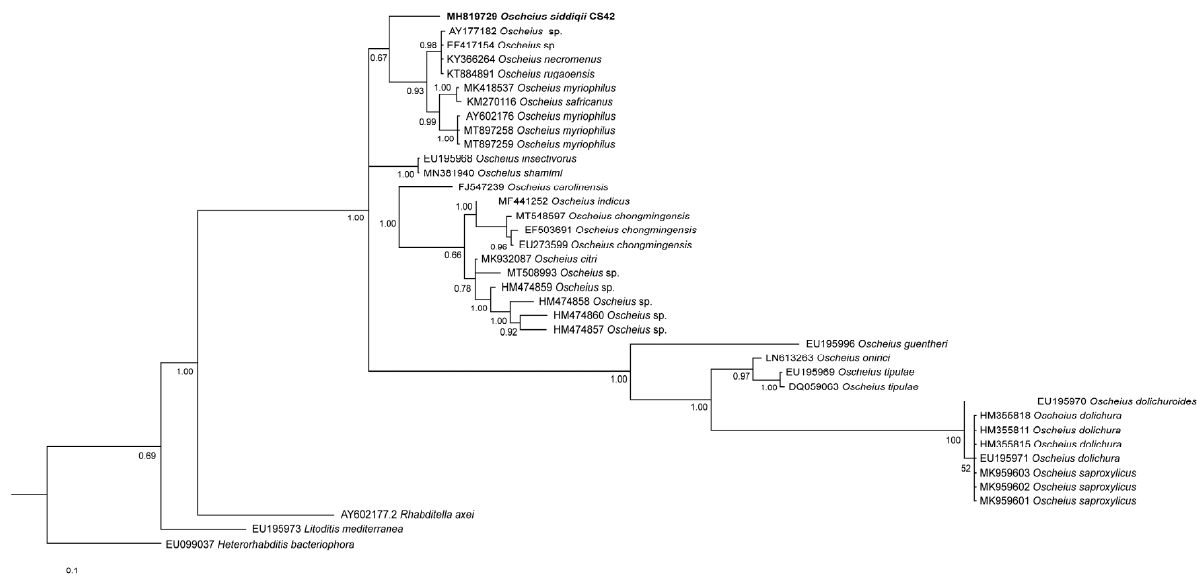
Figure 7. Phylogenetic relationships of Oscheius siddiqii and other Oscheius species as inferred from Bayesian analysis of sequences of the D2–D3 fragments of large subunit (28S) of rDNA region. Bayesian posterior probabilities (%) higher than or equal to 60% are provided at each node. The scale bar indicates the number of substitutions per